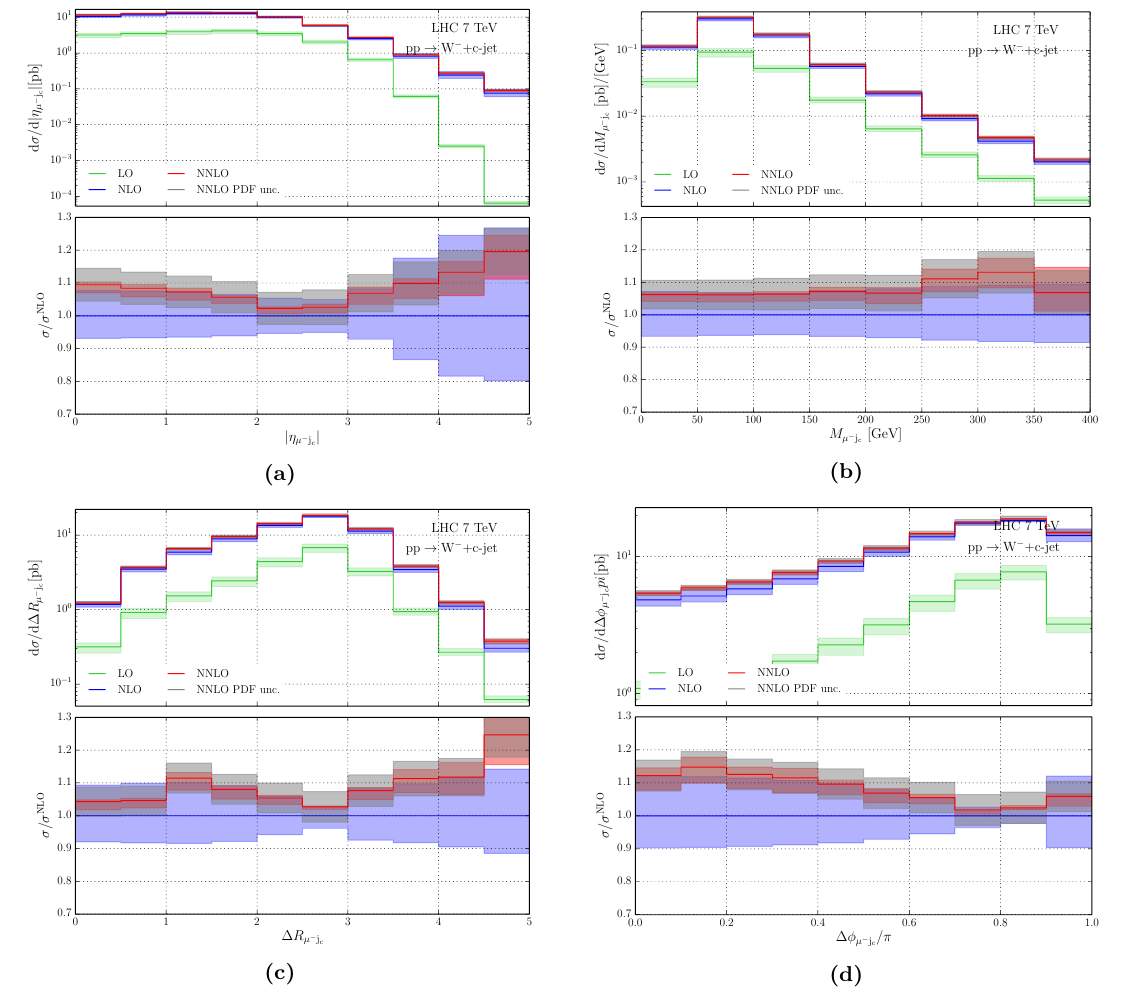
Figure 4. As in figure 3 but for the pseudo-rapidity of the muon and c-jet system (top left), invariant mass of the muon and c-jet (top right), rapidity-azimuthal-angle distance between the muon and c-jet (bottom left), and azimuthal angle between the muon and c-jet (bottom right).